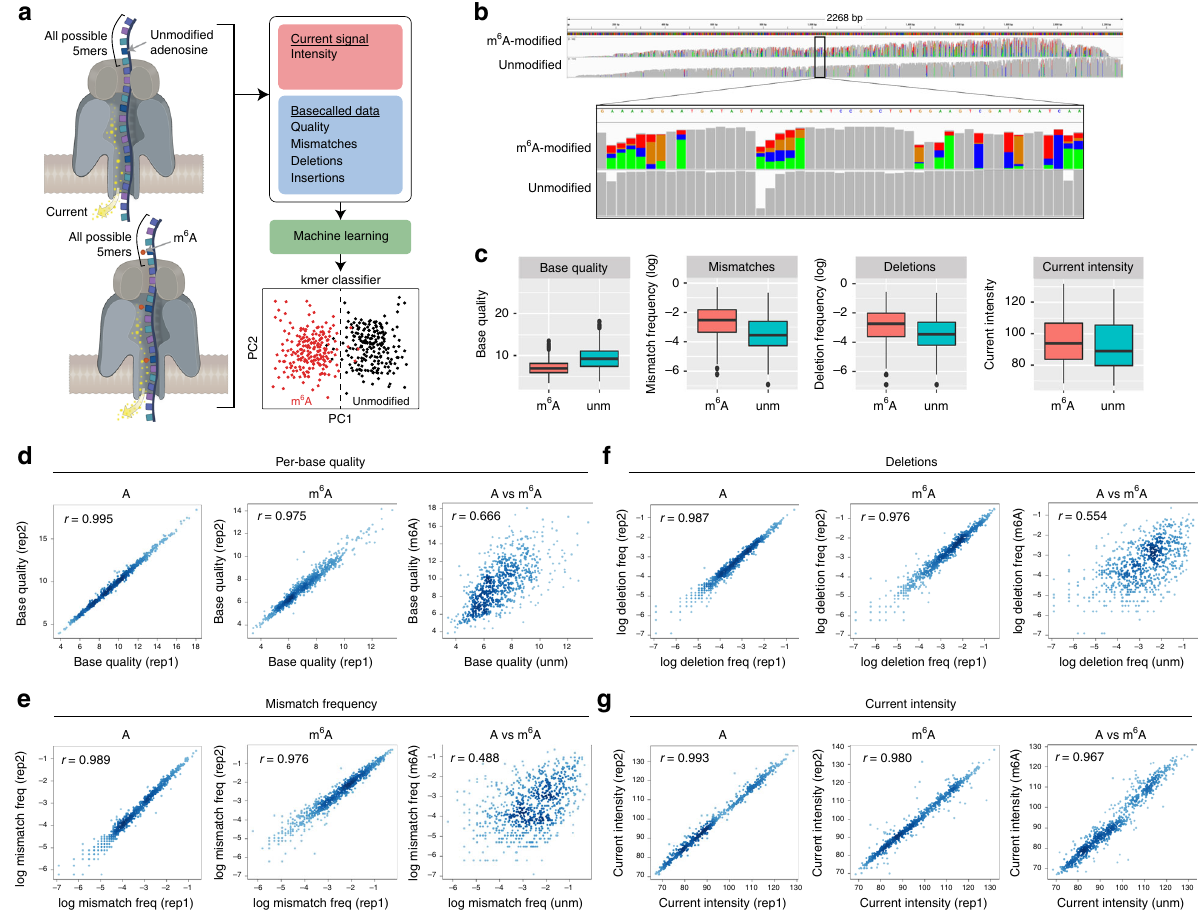
Fig. 1 Base-calling “ errors ” can be used as a proxy to identify RNA modi fi cations in direct RNA sequencing reads. a Schematic overview of the strategy used in this work to train and test an m 6 A RNA base-calling algorithm. b IGV snapshot of one of the four transcripts used in this work. In the upper panel, in vitro transcribed reads containing m 6 A have been mapped, whereas in the lower panel the unmodi fi ed counterpart is shown. Nucleotides with mismatch frequencies >0.05 have been colored. c Comparison of m 6 A and A positions, at the level of per-base quality scores (left panel), mismatch frequencies (middle left panel), deletion frequency (middle right panel), and mean current intensity (right panel). All possible k-mers (computed as a sliding window along the transcripts) have been included for these comparisons ( n = 9974). d – g Replicability of each individual feature — base quality ( d ), deletion frequency ( f ), mismatch frequency ( e ), and current intensity ( g ) — across biological replicates, for both unmodi fi ed ( “ A ” ) and m 6 A-modi fi ed ( “ m 6 A ” ) data sets. Comparison of unmodi fi ed and m 6 A-modi fi ed ( “ A vs m 6 A ” ) is also shown for each feature. Correlation values shown correspond to Spearman ’ s rho. Error bars indicate s.d. Source data are provided in the Source Data fi control k-mer set — which do not contain the modi fi cation — (Fig. 2f, Supplementary Fig. 3), suggesting that features from neighboring positions should not be employed with this model.